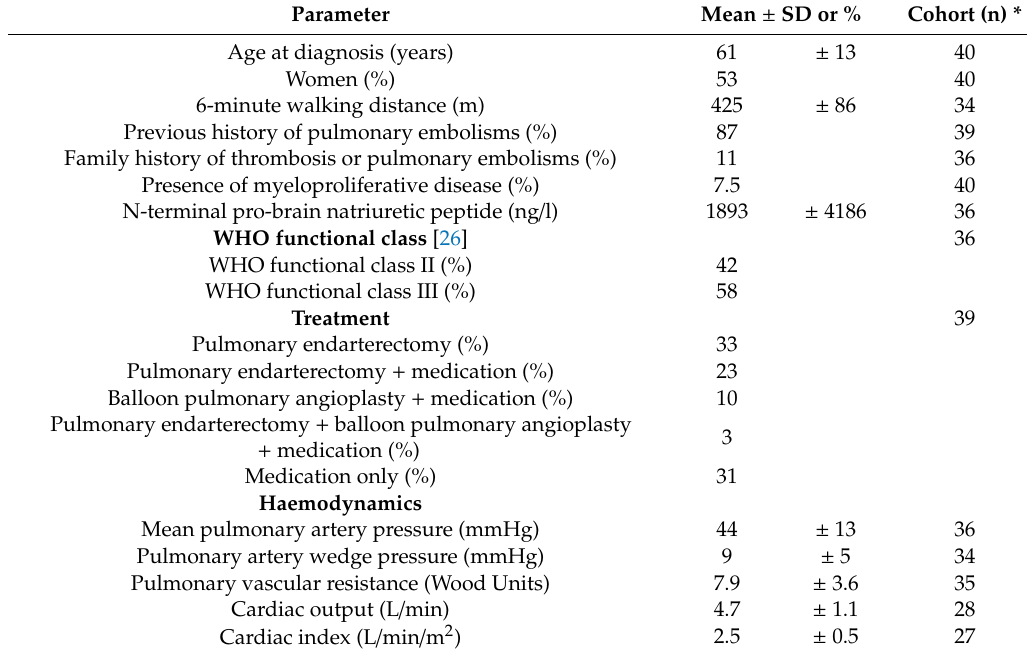
Table 1. Clinical characteristics of chronic thromboembolic pulmonary hypertension (CTEPH)